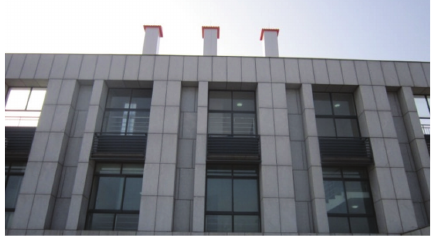
Figure 11: A picture of the imaging scenario.